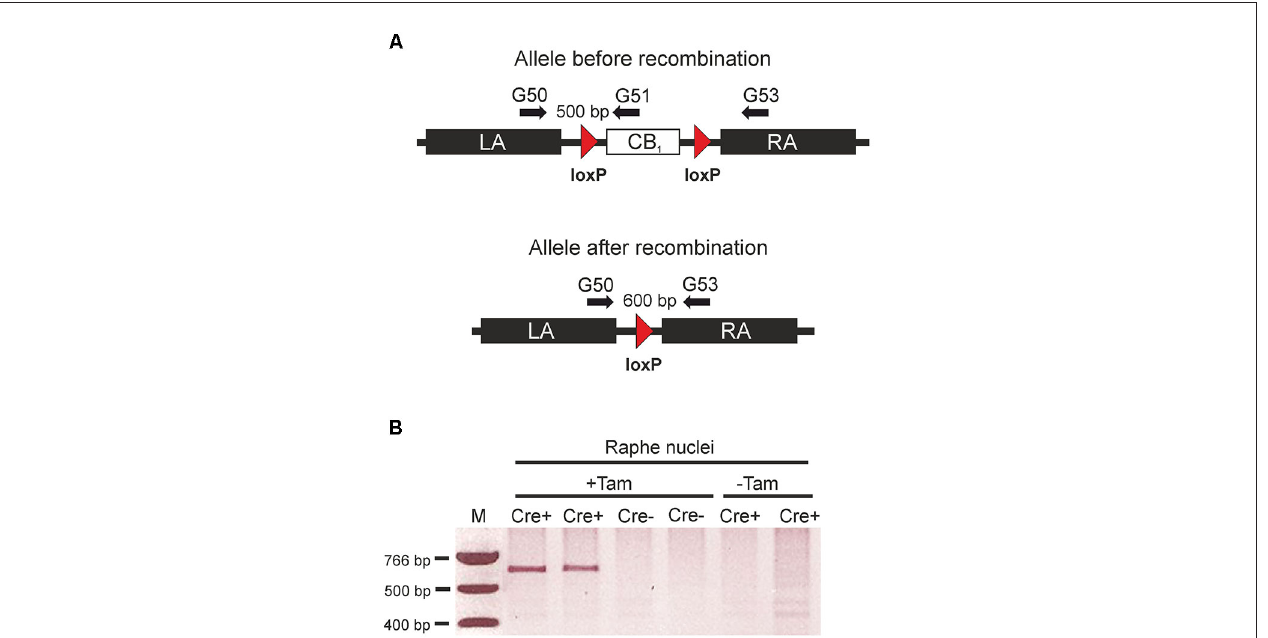
FIGURE 1 | Tamoxifen-inducible genetic inactivation of cannabinoid type 1 (CB 1 ) receptor in TPH2-positive neurons. (A) Schematic illustrations of CB 1 fl / fl allele before (above) and after Cre recombinase-mediated recombination (below). Arrows indicate primer positions. (B) Applying primers G50/G53, polymerase chain reaction (PCR) reactions were run using genomic DNA from the raphe nuclei region as a template. The 600 bp band indicating successful recombination was only detected in mice containing the CreER T2 transgene. (Cre+) after treatment with tamoxifen (+Tam). LA, left homology arm; RA, right homology arm; Cre+, animals heterozygous for the CreER T2 transgene and homozygous for the CB 1 fl / fl allele. Cre- = CB 1 fl / fl mice without the CreER T2 transgene; +Tam, tamoxifen-treated; − Tam, vehicle-treated; M, DNA size marker.